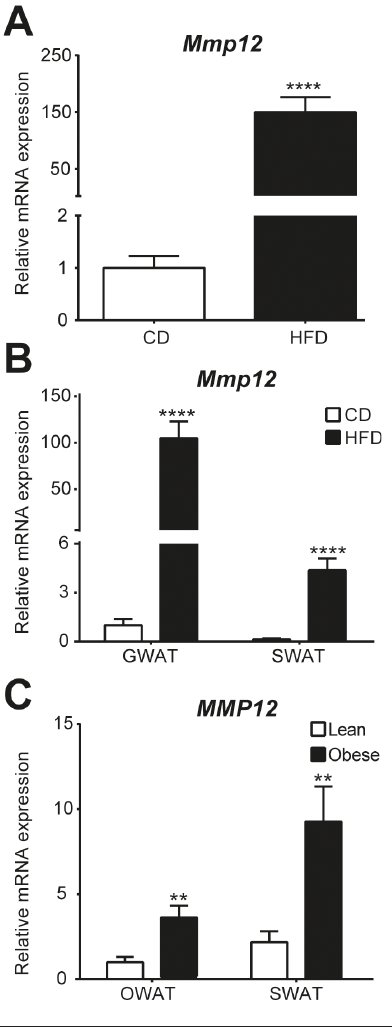
Figure 2. Gene expression of Mmp12/ MMP12 in obese mouse/human adipose tissue. Total RNA was extracted from GWAT and SWAT from mice (A and B) and hu- mans (C), respectively. (A) Mmp12 expres- sion in GWAT of WT mice fed HFD or CD from the microarray experiment was an- alyzed by RT-PCR with mice on CD being set to 1; n = 12 mice of each condition; (B) Mmp12 expression in GWAT and SWAT of WT mice fed HFD or CD was analyzed by RT-PCR in a separate experiment with mice on CD being set to 1; n = 15 mice of each Figure 3. Identification of MMP12 protein expression in white adipose tissue from diet condition; (C) MMP12 expression in OWAT induced obese mice. Protein extracts from GWAT and SWAT from 23-wks old mice after and SWAT from obese and lean subjects, 14 wks on HFD or CD, respectively, was analyzed by Western blot and zymography for OWAT of lean human was set to 1; n = 12 MMP12. β -actin was used as a loading control in Western blot. (A) Representative image of each group. Results are expressed as of 4 Western blots (n = 8 mice per condition) are shown. (B) Quantification of total mean ± SEM. * p < 0.05; ** p < 0.01; MMP12 protein expression in GWAT and SWAT on CD and HFD. (C) Quantification of ac- *** p < 0.001 and **** p < 0.0001 compared tive MMP12 protein expression in GWAT and SWAT on CD and HFD. Results are expressed with CD (A, B) or lean (C), respectively. as mean ± SEM.° p = 0.09 ; * p < 0.05; ** p <